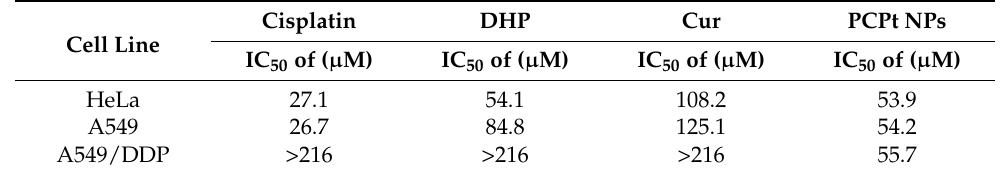
Table 3. The IC 50 of drugs towards different cell lines for 48 h